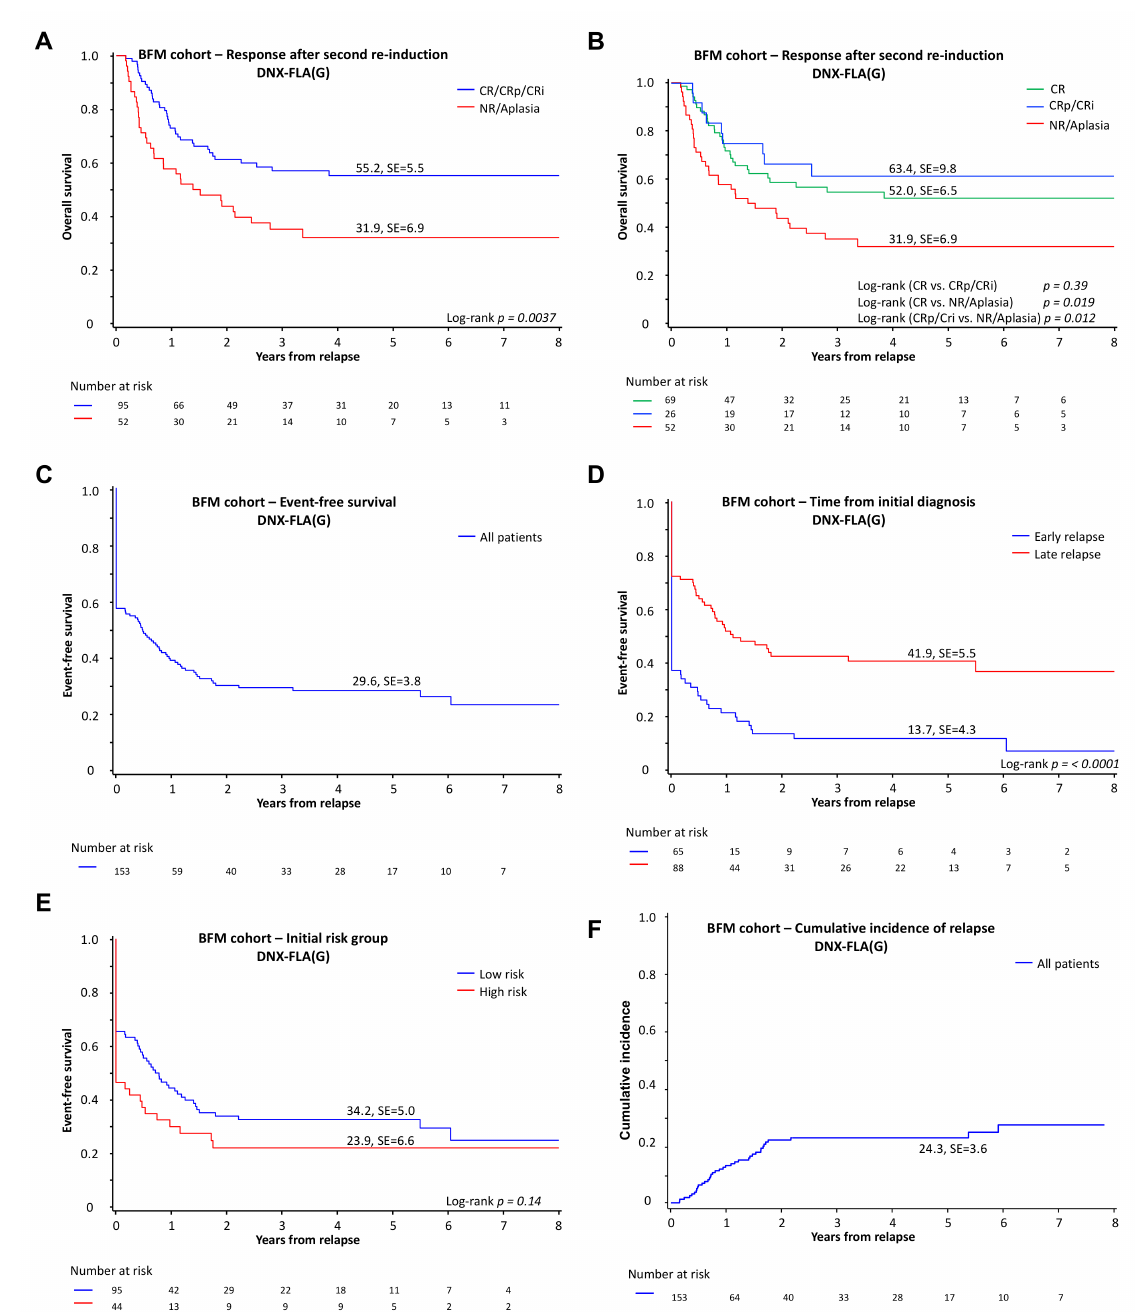
Figure 3. Response and EFS at first relapse. ( A ) Five-year overall survival in patients with pediatric AML with first relapse based on the response to DNX-FLA(G) +/ − FLA(G) comparing complete remission with complete (CR) and partial regeneration (CRp) and CRi vs. nonresponse and aplasia. ( B ) Five-year overall survival in patients with pediatric AML with first relapse based on the detailed response to DNX-FLA(G) +/ − FLA(G). ( C ) Five-year event-free survival in all patients receiving DNX-FLA(G) +/ − FLA(G) after first relapse. ( D ) Five-year event-free survival of patients with early or late relapse defined as relapse within or after one year of initial diagnosis. ( E ) Five-year event-free survival in patients with first relapse based on the risk profile of the initial diagnosis. ( F ) Five-year cumulative incidence of a second relapse in all patients receiving DNX-FLA(G) +/ − FLA(G). The competing event is death. Abbreviations: HR, high-risk. DNX-FLA(G), liposomal daunorubicin, fludarabine, cytarabine with or without granulocyte-colony-stimulating factor. CR, complete remission; CRp, complete remission with partial regeneration; Cri, complete remission with incomplete recovery. See Table S1 for